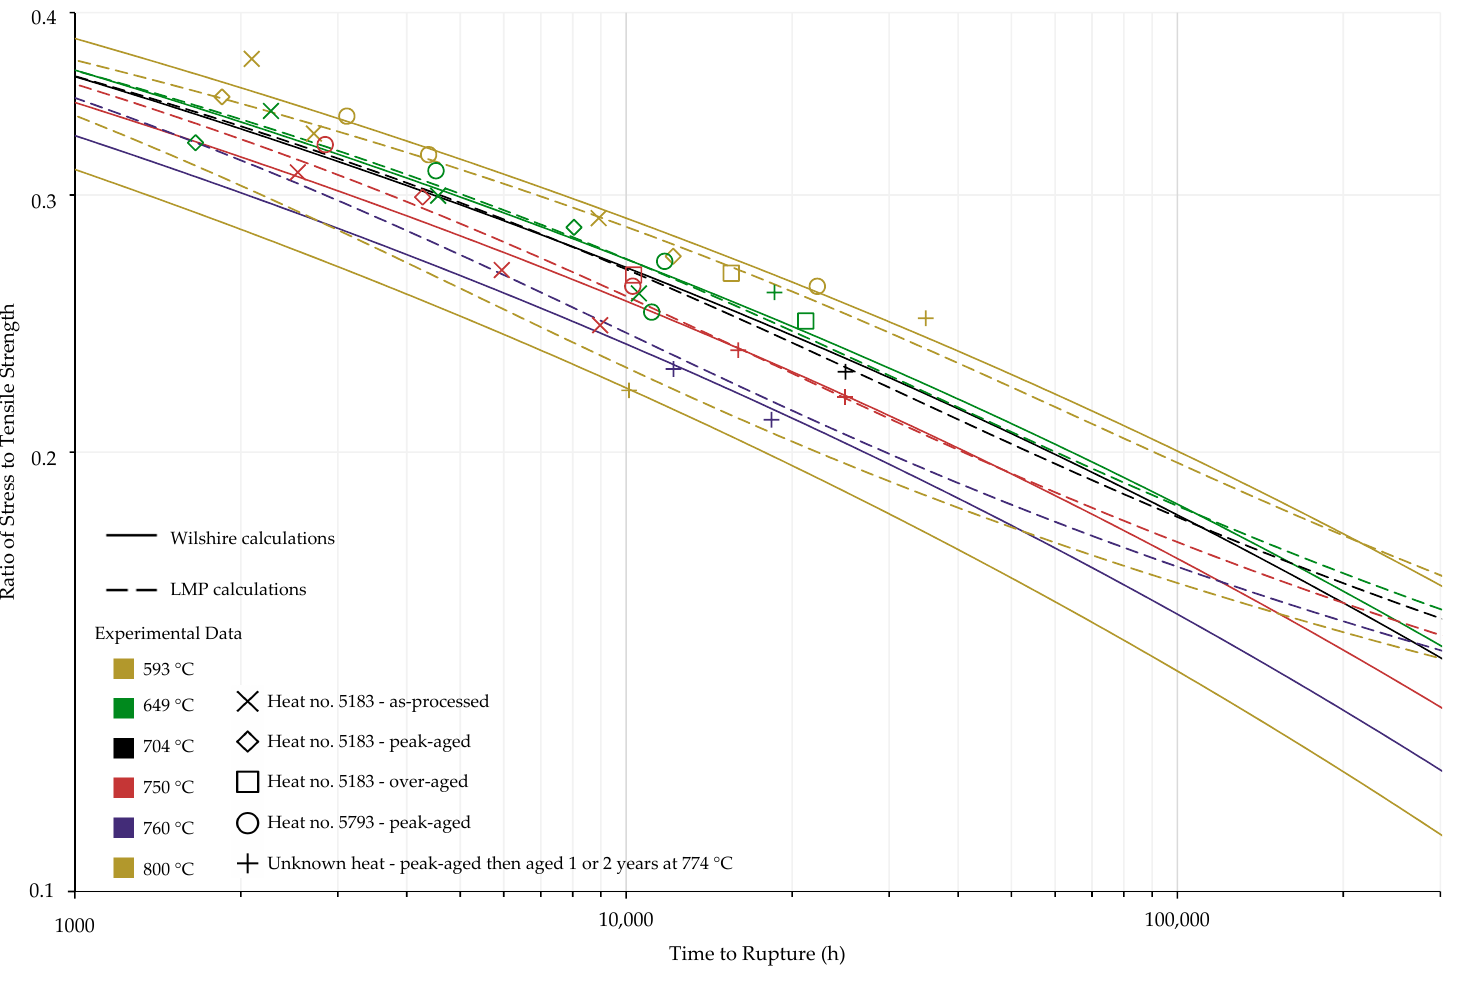
Figure 14. Calculated rupture times for Nimonic 105.